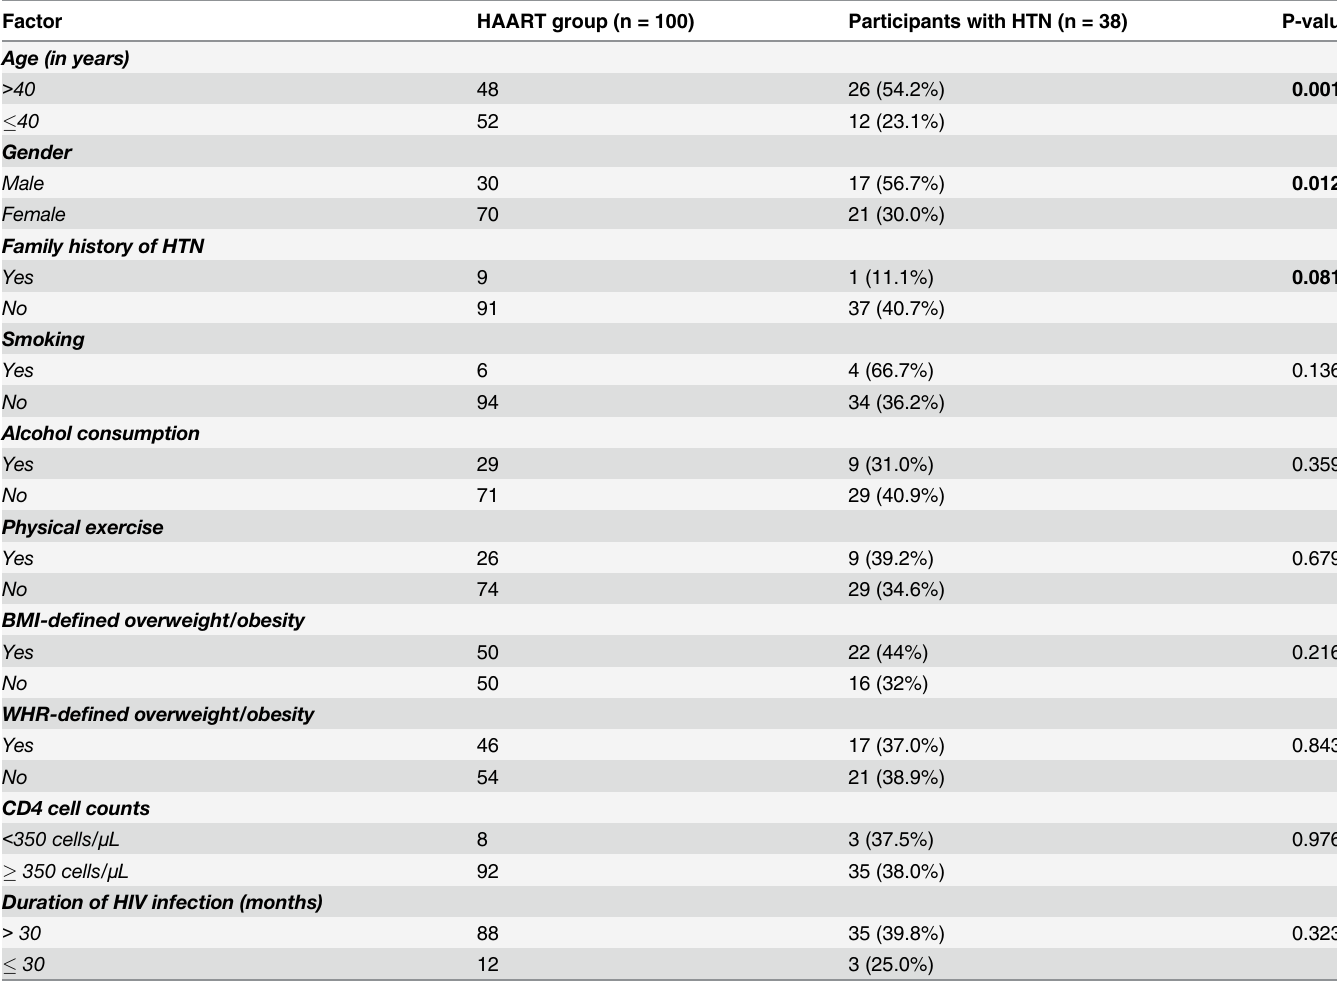
Table 3. Factors associated with hypertension in the HAART